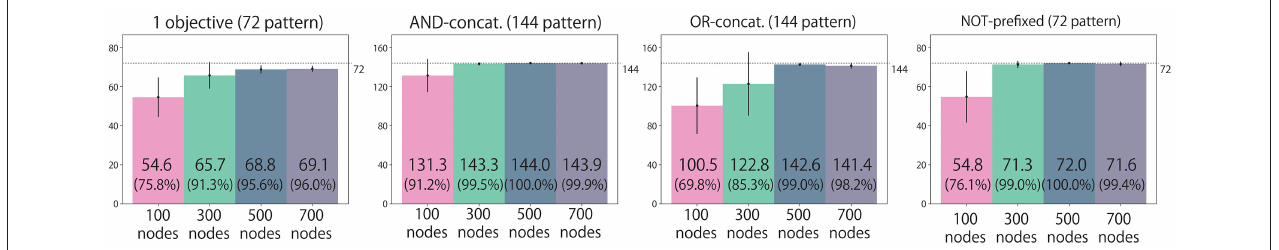
FIGURE 13 | Experiment 2 (bell task). Action generation performance. We evaluated performance by counting how many situation patterns each model learned appropriately with respect to each of the four situation types: (1) the instruction includes one objective; (2) the instruction is AND-concatenated; (3) the instruction is OR-concatenated; and (4) the instruction is NOT-prefixed. The written values are averages of 10 trials in which learning began with different seeds. Error bars represent standard deviations.